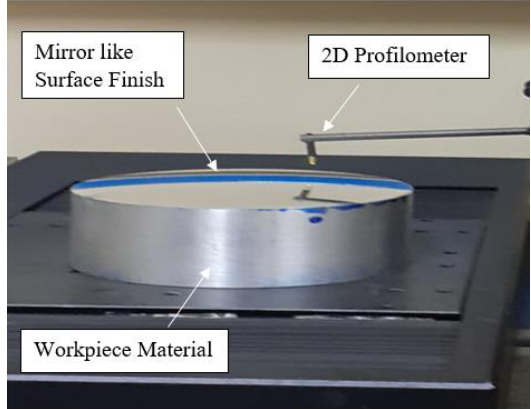
Figure 10. The final mirror-like surface finish on the Stavax workpiece.